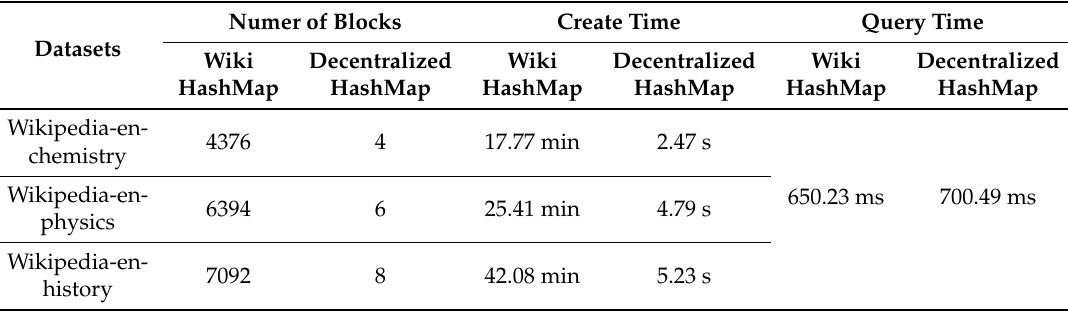
Table 1. The comparison of Wiki HashMap and Decentralized